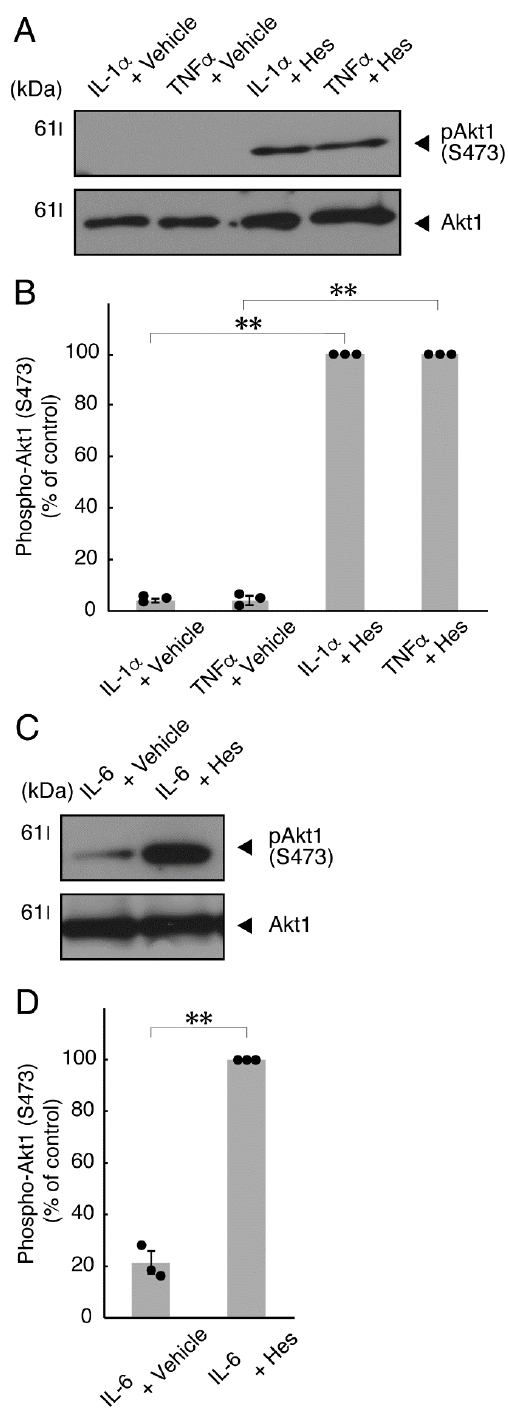
Figure 10. Hesperetin recovers inhibition of Akt kinase phosphorylation by TNF α or IL-6. ( A , B ) Cells were treated with TNF α or IL-1 α in the presence of control vehicles or hesperetin (Hes). The (pS473)Akt1 or Akt1 blot is shown. Immunoreactive band intensities for (pS473)Akt1 were also compared to be depicted in graphs (**, p < 0.01; n = 3 blots [obtaining one sample each from 3 independent experiments]). ( C , D ) Cells were treated with IL-6 in the presence of control vehicles or hesperetin. The (pS473)Akt1 or Akt1 blot is shown. Immunoreactive band intensities for (pS473)Akt1 were also compared to be depicted in graphs (**, p < 0.01; n = 3 blots [obtaining one sample each from 3 independent experiments]). The vertical values in graphs were evaluated as (pS473)Akt1/total